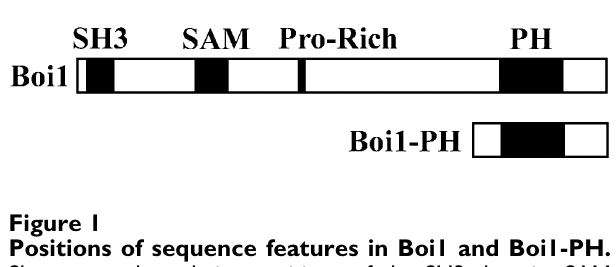
Figure 1 Positions of sequence features in Boi1 and Boi1-PH. Shown are the relative positions of the SH3 domain, SAM domain, proline-rich region, and PH domain. Full-length Boi1 is 980 amino acids long. Boi1-PH is the segment of Boi1 from amino acid position 734 through